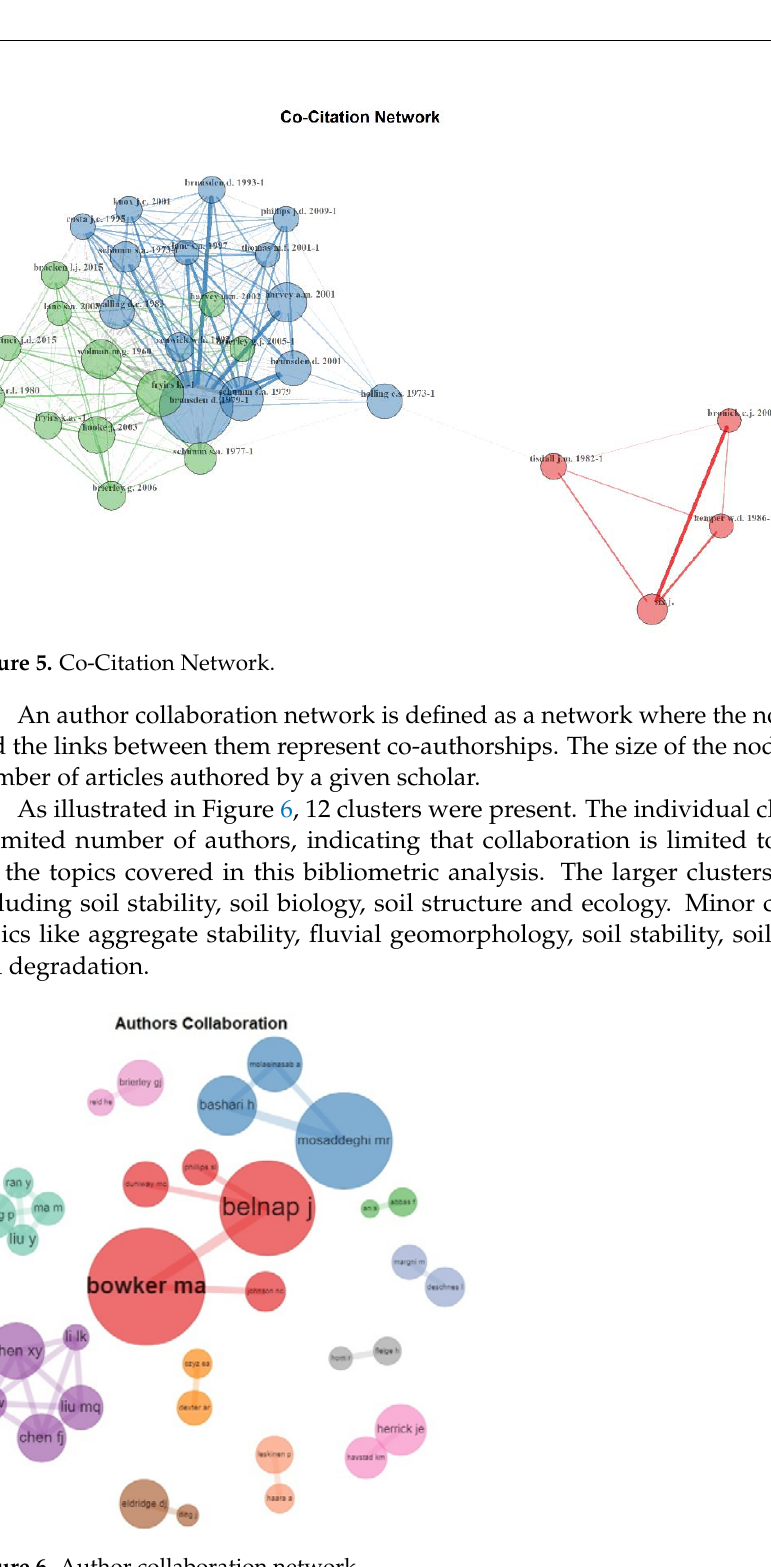
Figure 6. Author collaboration network.